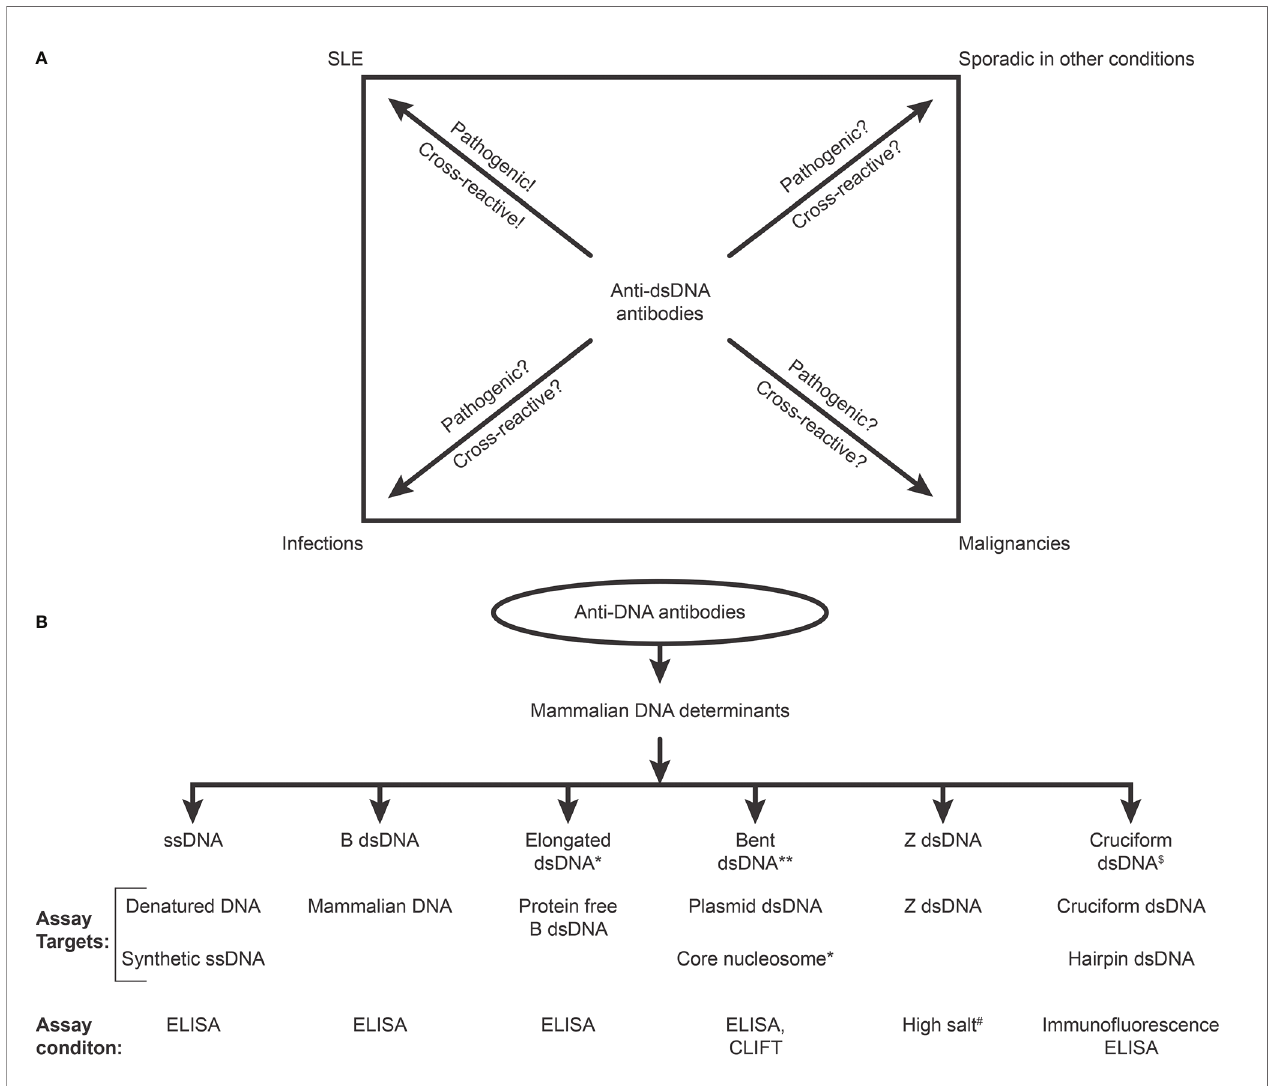
FIGURE 2 | Critical questions related to the SLE classi fi cation criterion “ The anti-dsDNA antibody ” (criterion 11 in ACR) or “ Anti-dsDNA ” (criterion 6, Immunological criteria, SLICC). Principal problems are linked to the inadequate terminology of the anti-dsDNA antibodies. One problem [demonstrated in (A) ] illustrates that “ The anti- dsDNA antibody ” is not unique for SLE, but appears regularly in context of infections, malignancies, and sporadic in other conditions. Little is examined whether anti- dsDNA antibodies are pathogenic and cross-reactive in the latter conditions [question marks in (A) ], as they truly are in SLE. The second dominant problem considered for the “ Anti-dsDNA antibody ” is that the antibodies are presented as if “ it ” is monospeci fi c for dsDNA without further speci fi cations of target DNA structures. This has over decades crystallized the conception that different assay systems detect antibodies possessing different avidities but not different speci fi cities! This con fl ict is principally [demonstrated in (B) ]. The “ ssDNA/dsDNA ” structures are categorized in 6 main sets. Antibodies against all these dsDNA structures have been identi fi ed by conventional assay systems, like ELISA in physiological salt (ssDNA, B DNA, elongated B DNA, bent B dsDNA), in high salt (Z dsDNA), and cruciform dsDNA in addition to heterogeneous binding to proteins and phospholipids. The idiom that anti-dsDNA antibodies bind dsDNA in a singular form as in the ACR or SLICC classi fi cation systems must be challenged by the multifaceted recognition pattern of anti-dsDNA antibodies as informed about in (B) Thus, data in this fi gure require that assay systems for anti-dsDNA antibodies relates to categorized structural DNA speci fi cities. Lack of implementation of the structural and molecular recognition pattern recognized by individual anti-dsDNA antibodies undermine the potential clinical impact of anti-dsDNA antibody sub-speci fi